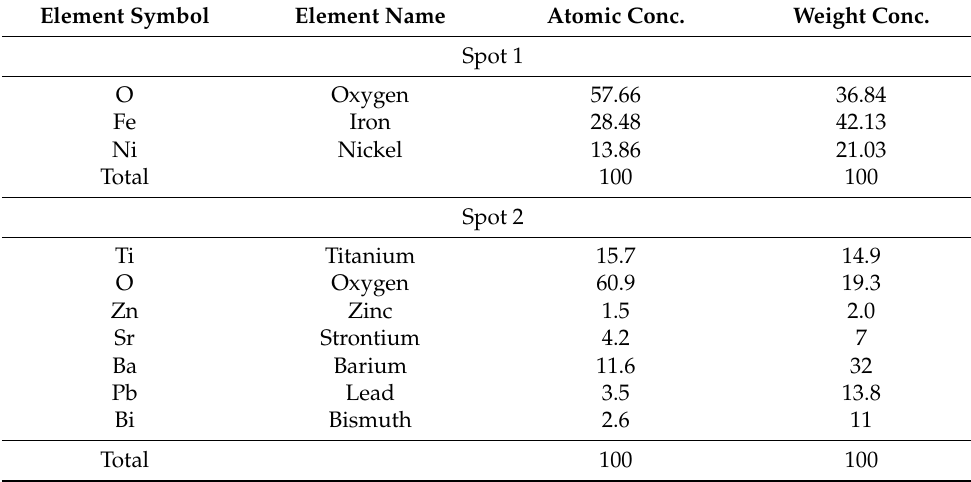
Table 1. EDS analysis